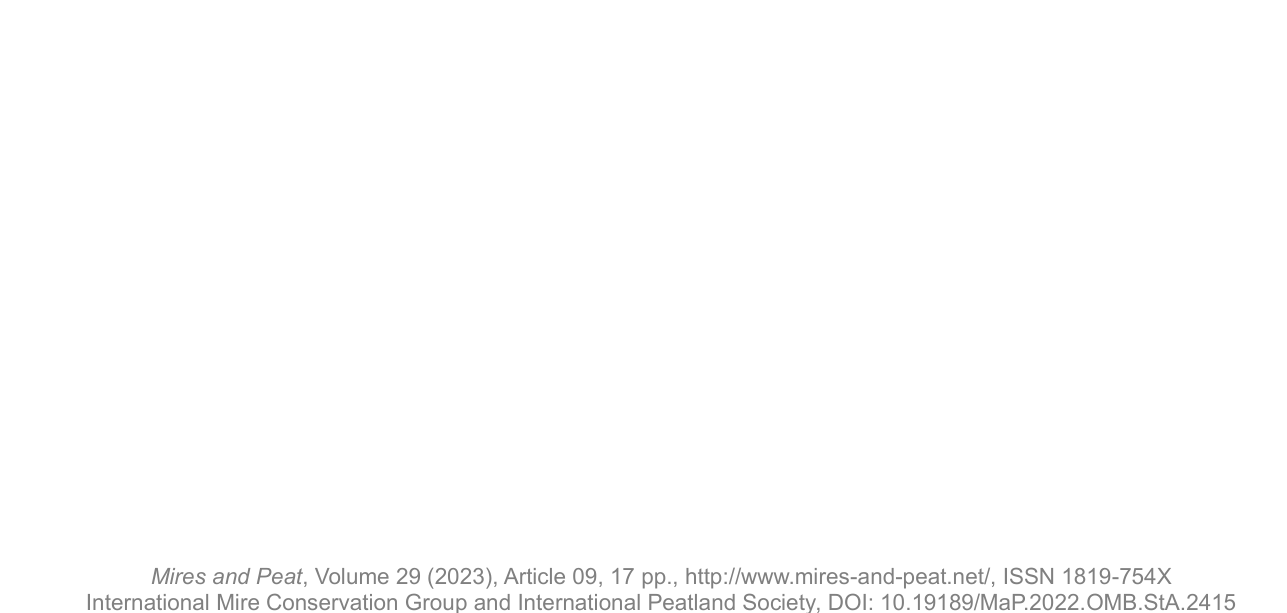
= 4.22 m; BD = 0.167 g cm -3 ; p